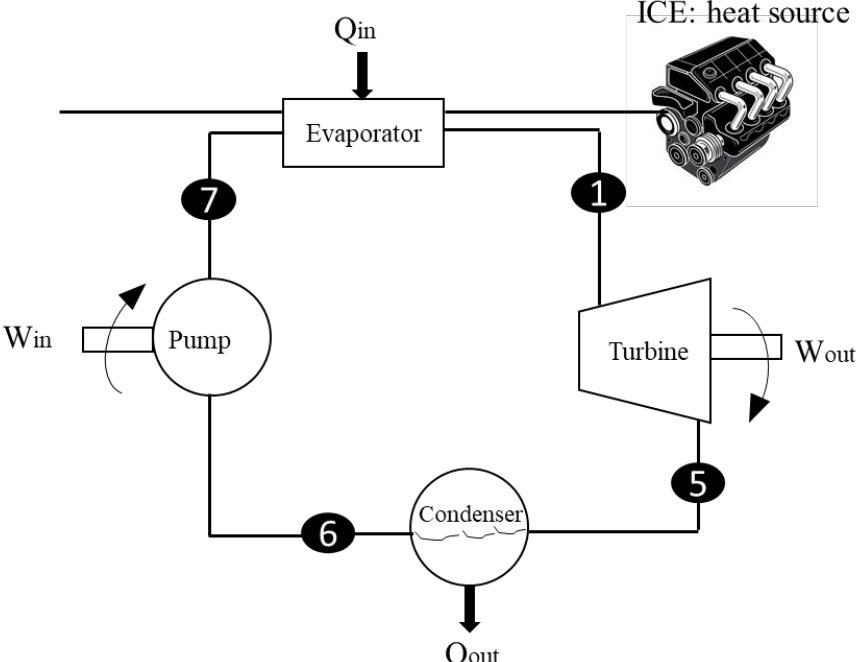
Figure 2. Schematic of typical organic Rankine cycle (ORC) coupled internal combustion engine (ICE).